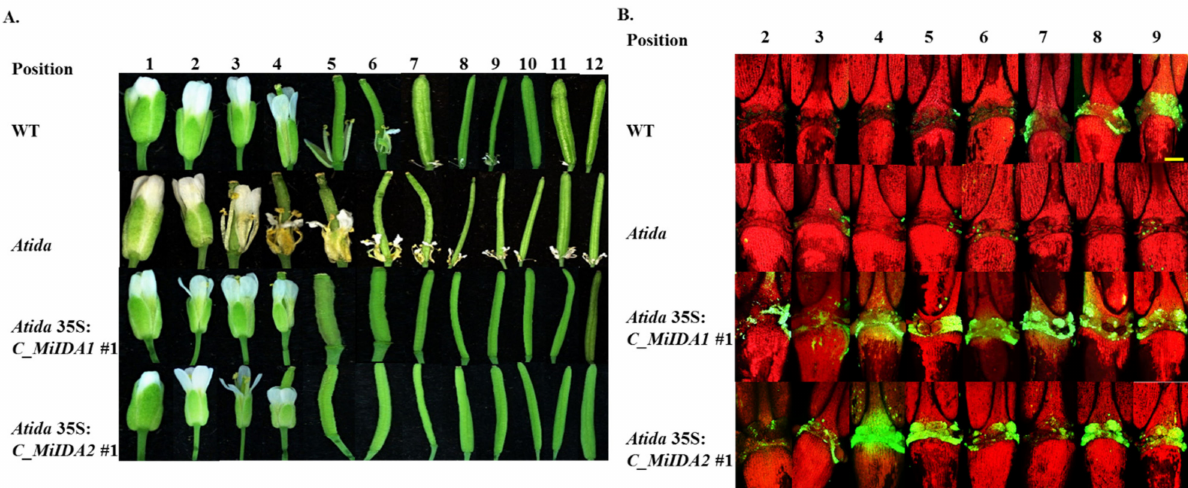
Figure 8. MiIDA1 and MiIDA2 complemented and restored floral organ abscission ability in an Atida mutant. ( A ) Compari- son of phenotypes of floral organ abscission in WT, Atida mutant, Atida 35S: C_MiIDA1 , and Atida 35S: C_MiIDA2 plants. ( B ) Representative BCECF fluorescence micrographs of floral organ AZs of Arabidopsis Col-0 (WT), an Atida mutant, and Atida 35S:C MiIDA -complemented plants. Flower position numbers are indicated, starting from the second flower at anthesis. Scale bar = 200 µ m. The images presented for each plant type (WT, mutant or complemented plants) are representative images of 3 or 4